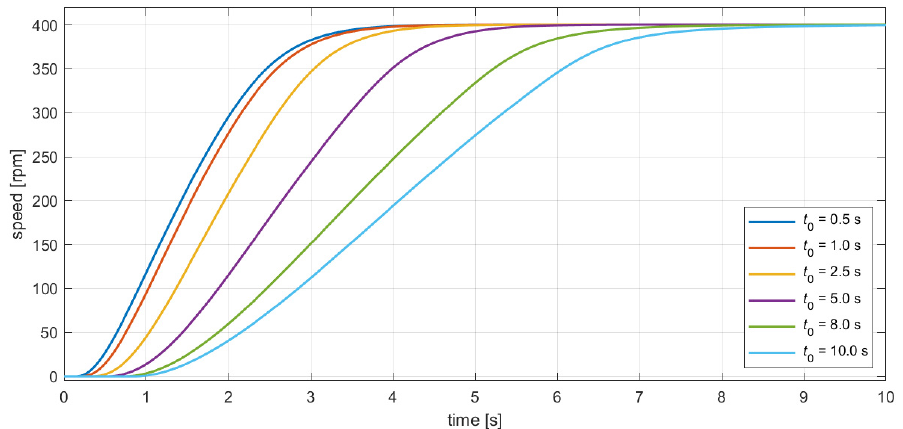
Figure 6. Result of simulation of the waveform of pressure on the motor 𝑝 (cid:3046) for various signal rise times, 𝑡 (cid:2868) .